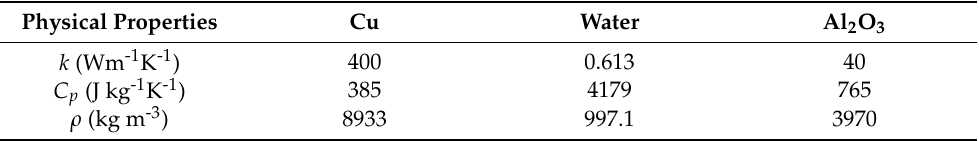
Table 2. Thermo physical properties of Cu, Al 2 O 3 and